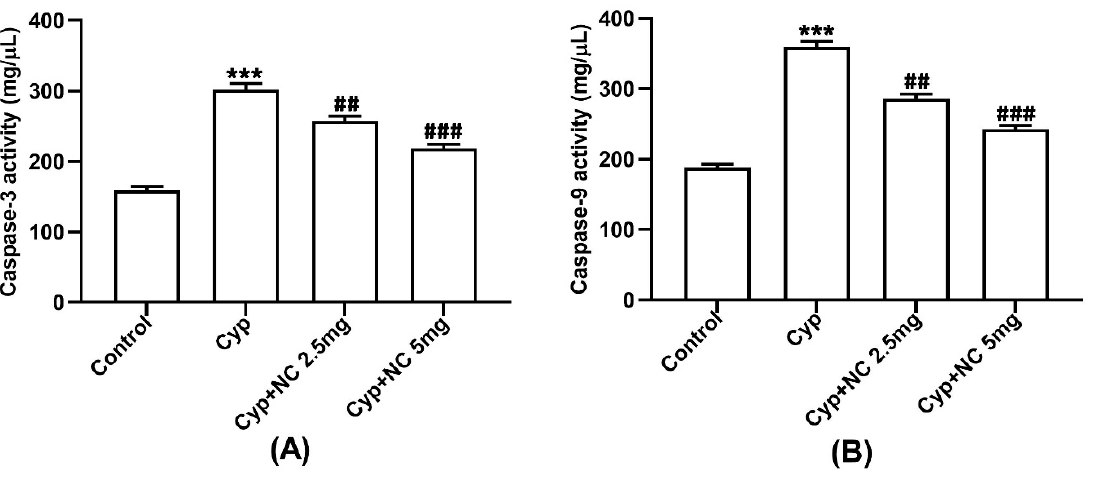
Figure 4. Effect of Cur-NLC treatment on apoptotic markers caspase-3 ( A ) and caspase-9 ( B ) up- regulated by Cyp. Values represented as mean ± SEM (n = 6). *** p < 0.001 vs. control, ## p < 0.01, ### p < 0.001 vs. Cyp group. Cyp = cypermethrin; NC = NLC.